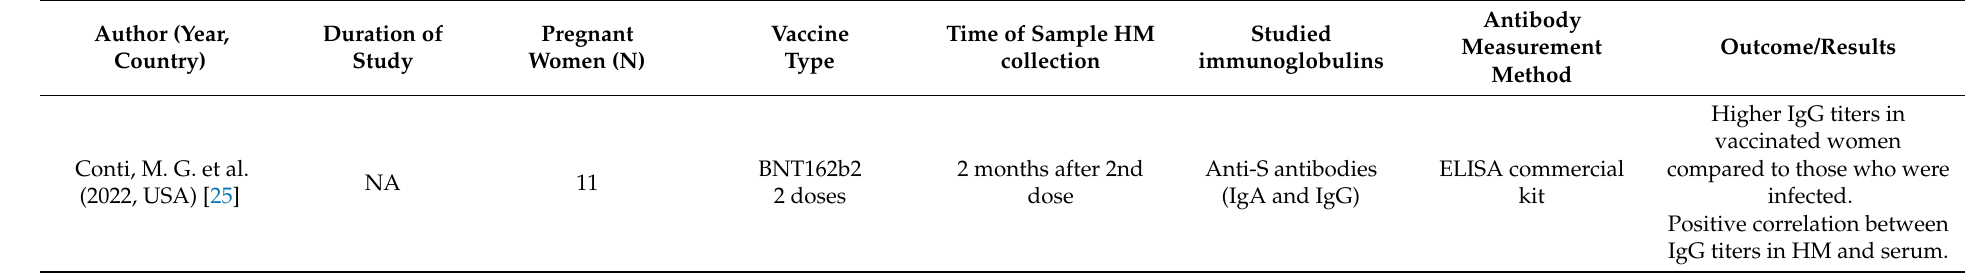
Table 3. Characteristics of included studies referring to vaccinated pregnant women not previously infected or